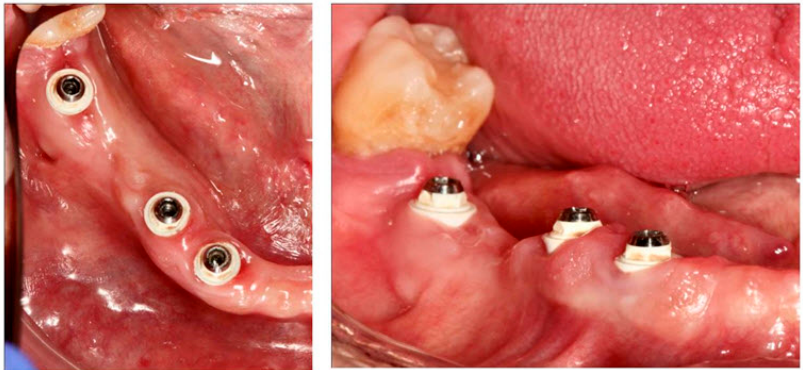
Figure 7. Peri-implant tissue surrounding the coated ceramic abutments one year after implant in- sertion.